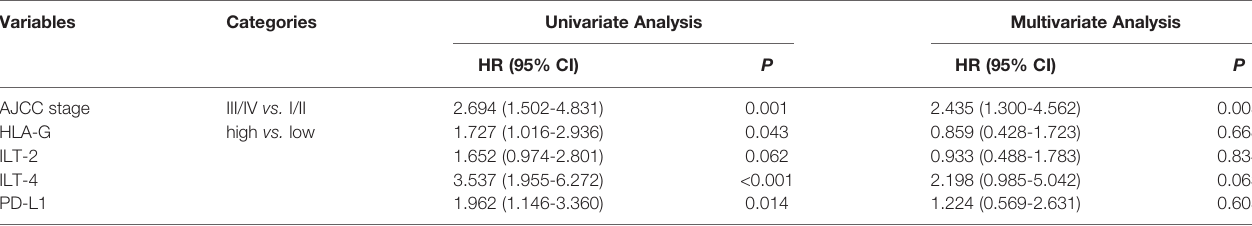
TABLE 4 | Cox regression analysis for prognostic value of variables for CRC